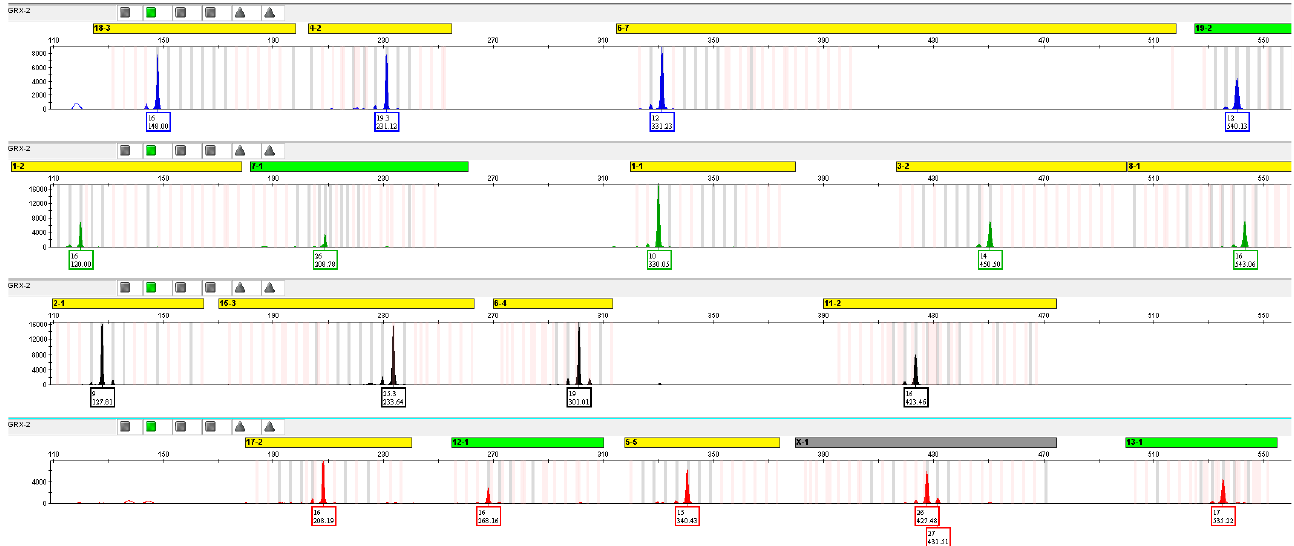
Figure 8. Extended electropherogram of GRX STR profile resulting from independent analysis with 18 markers. DNA from GRX cells were isolated and the genetic profile obtained by using the STR markers 1-1, 1-2, 2-1, 3-2, 4-2, 5-5, 6-4, 6-7, 7-1, 8-1, 11-2, 12-1, 13-1, 15-3, 17-2, 18-3, 19-2, and STR X-1, respectively.